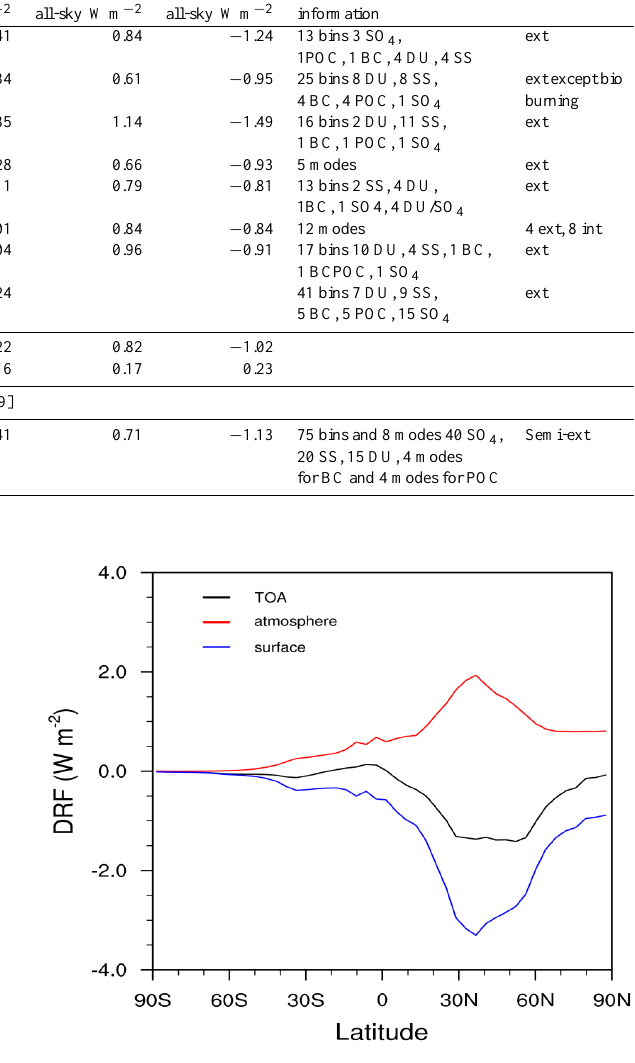
Fig. 8. Zonal mean anthropogenic aerosol DRF at TOA, atmosphere and surface for all sky. Unit: Wm − 2